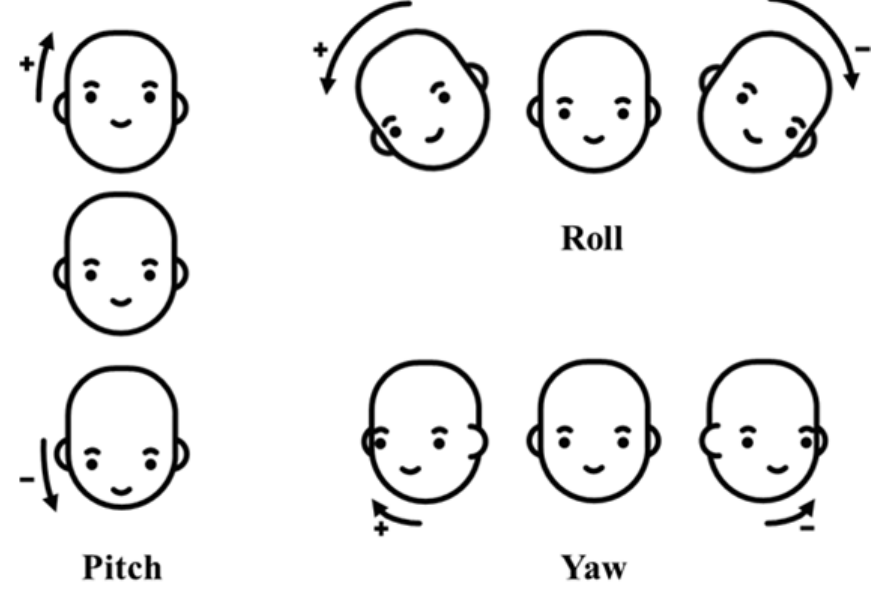
Figure 7. Yaw, roll, and